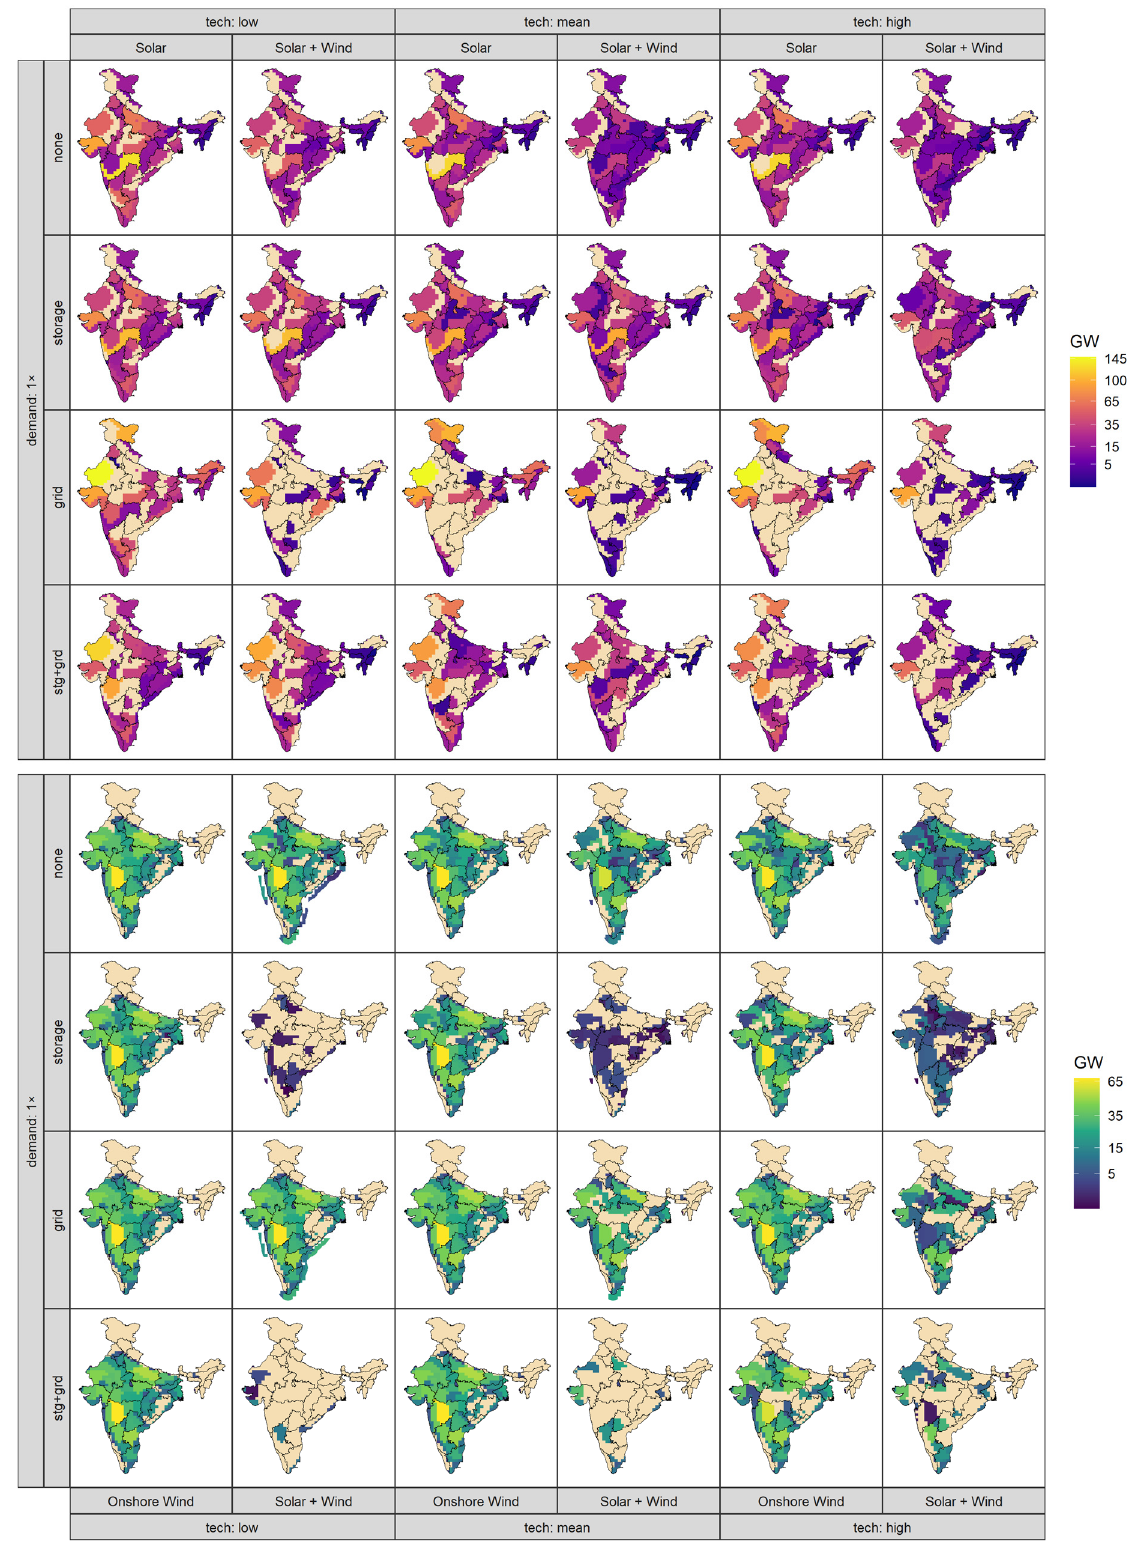
Figure A12. Optimised solar and wind generation capacity by scenario and cluster, demand level equal to 2019 (1×).